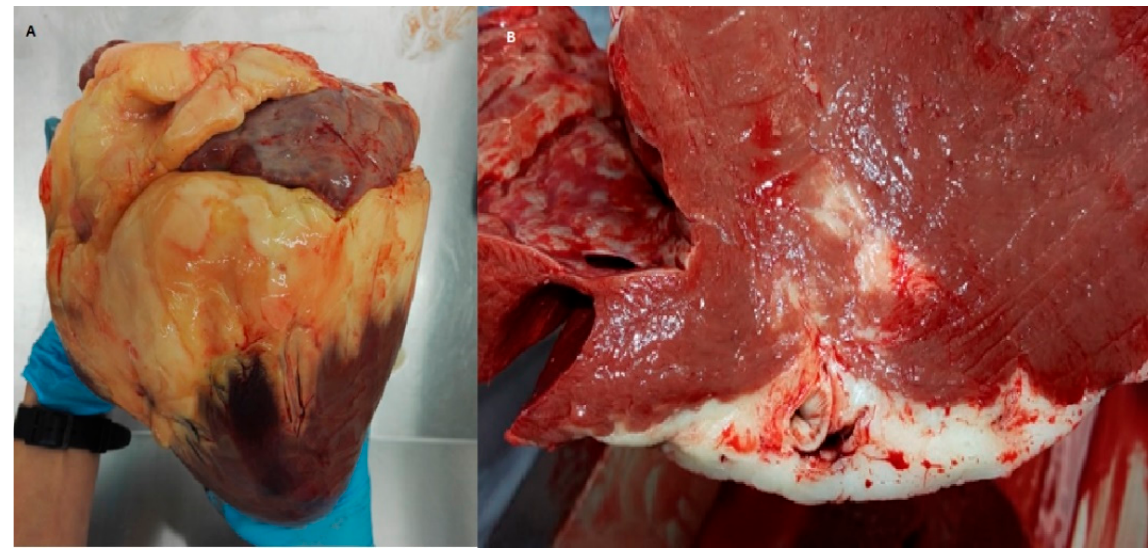
Figure 1. Macroscopic image of the whole isolated heart from an extremely obese horse. ( A ) Hearts surrounded by pericardial fat. ( B ) Cross section of the heart wall with increased amount of pericardial fat, infiltrating the heart wall.